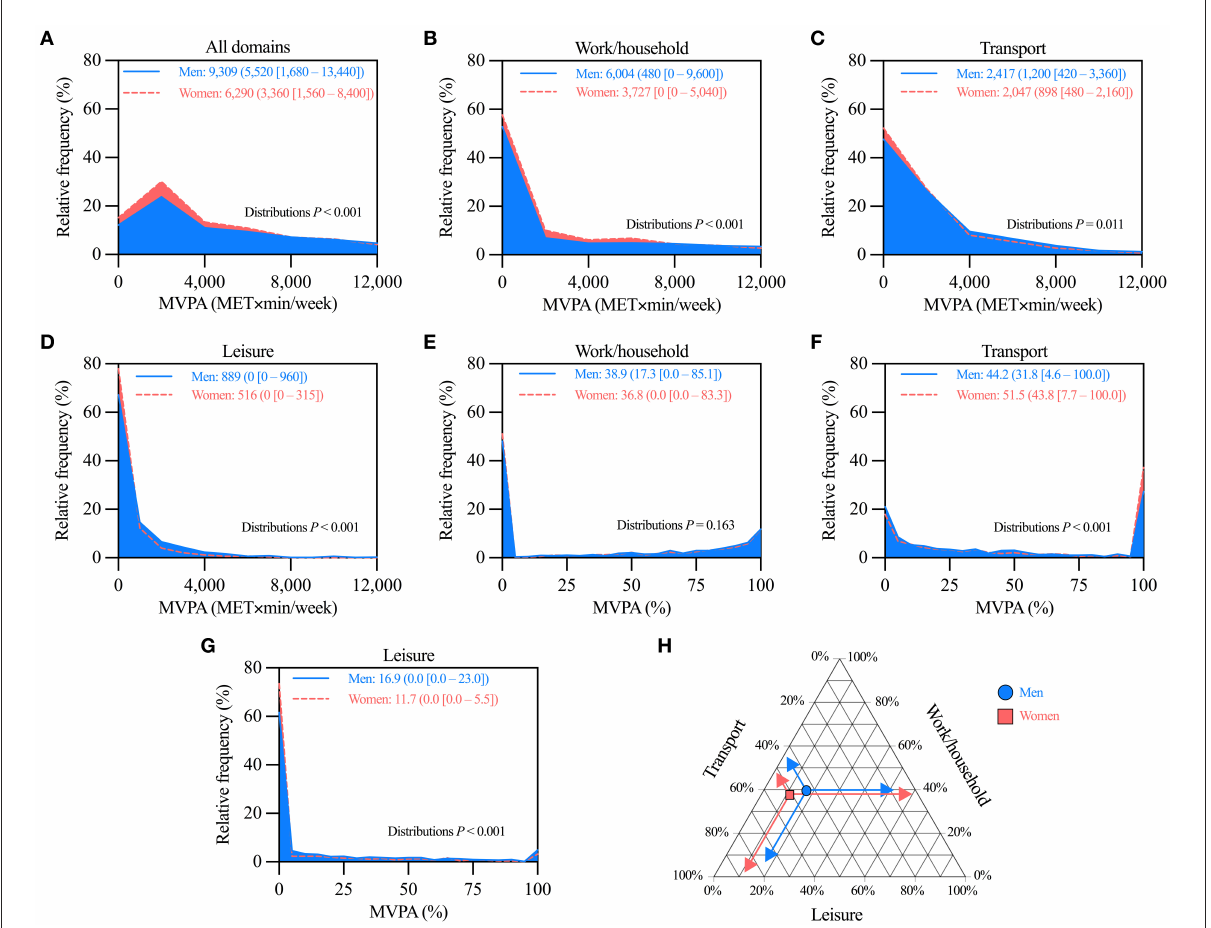
FIGURE3 Comparison of moderate-vigorous physical activity (MVPA) levels between men and women categorized as active. (A–D) Histograms comparing the distributions of MVPA considering (A) all, (B) work/household, (C) transport, and (D) leisure domains. (E–G) Histograms comparing the distributions of the relative contribution to MVPA of (E) work/household, (F) transport, and (G) leisure domains. (H) Ternary plot summarizing the mean relative contribution to MVPA by domain in men and women. In panels A–G , values are mean (median [25–75th percentile]) of MVPA; distributions more skewed to low MVPA values denote lower MVPA. n = 1,328 for men, and 1,884 for